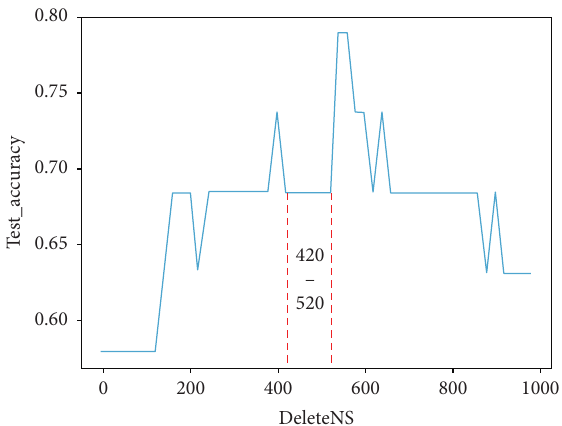
Figure 4: Curve 4 of deleteNS and classification accuracy. Table 3: Test results of classification